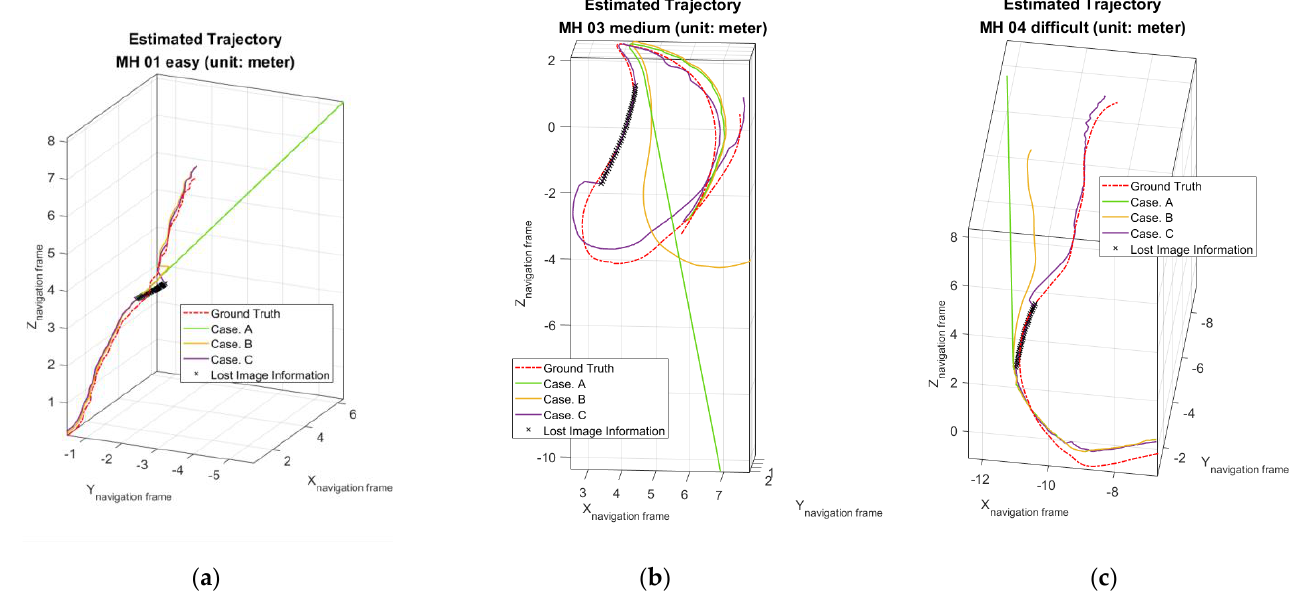
Figure 25. Estimated trajectories in anti − shading robustness test: ( a ) For MH_01_easy series; ( b ) For MH_03_medium series; ( c ) For MH_04_difficult series.